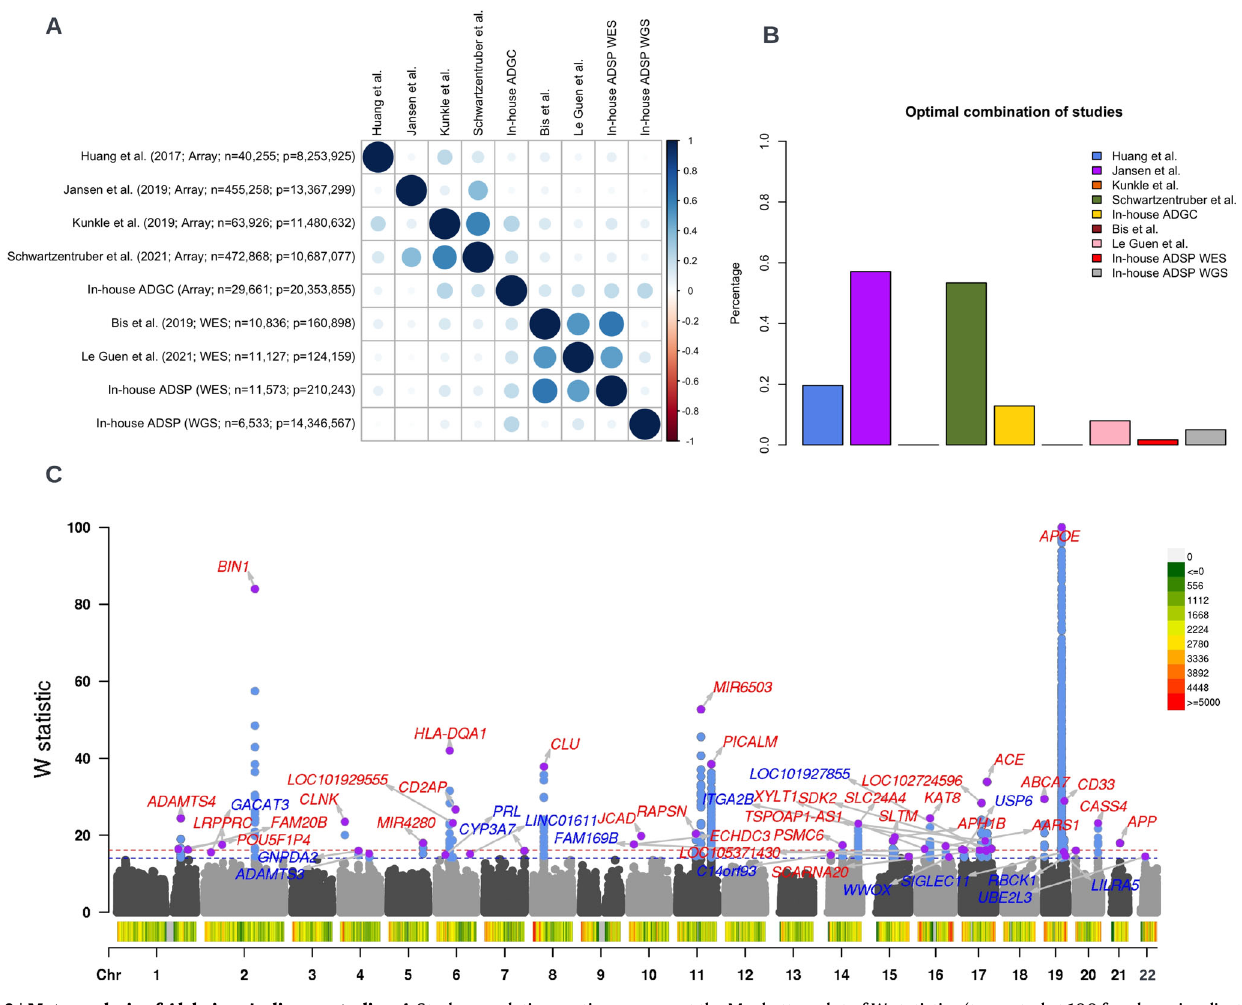
present theManhattanplotof Wstatistics(truncatedat 100forclearvisualization) from GhostKnockoff with target FDR at 0.05 (red) and 0.10 (blue). The results are basedon the optimalweightscombining the nine studies. Variantdensity is shown at the bottom of Manhattan plot (number of variants per